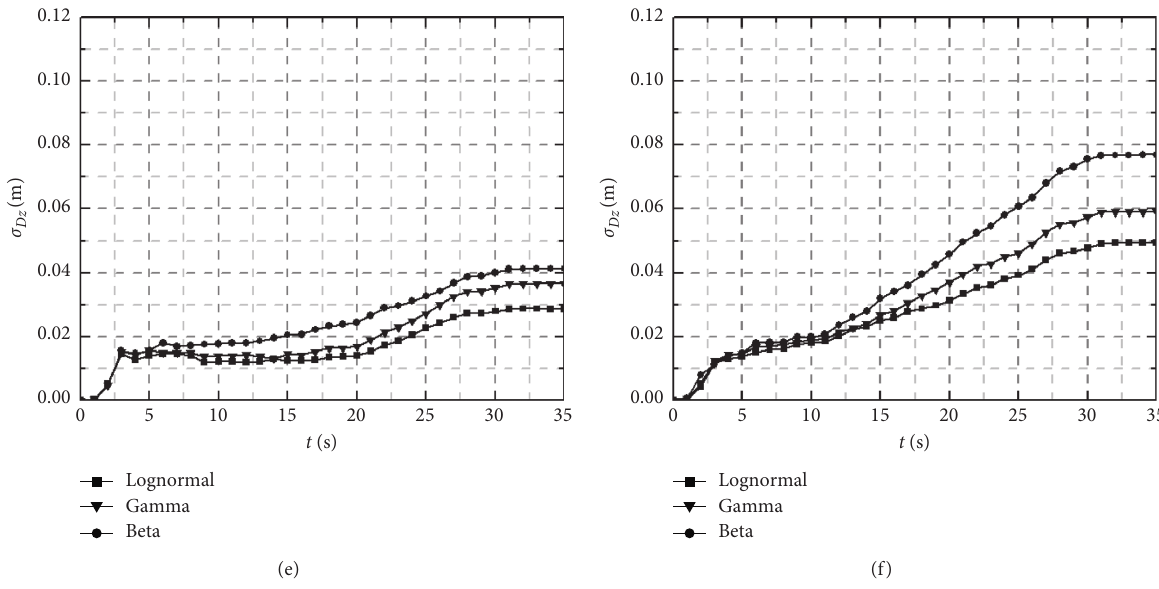
Figure 8: Time history curve of σ